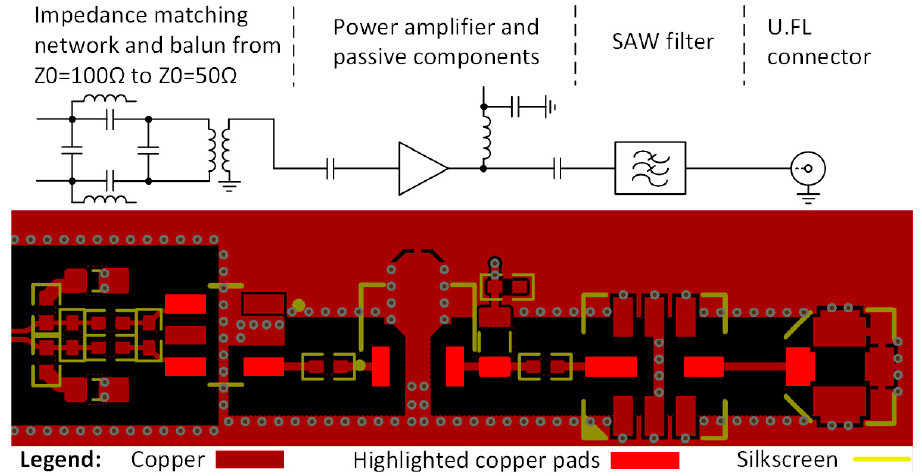
Figure 1. A common radio frequency (RF) chain in modern high-frequency devices.